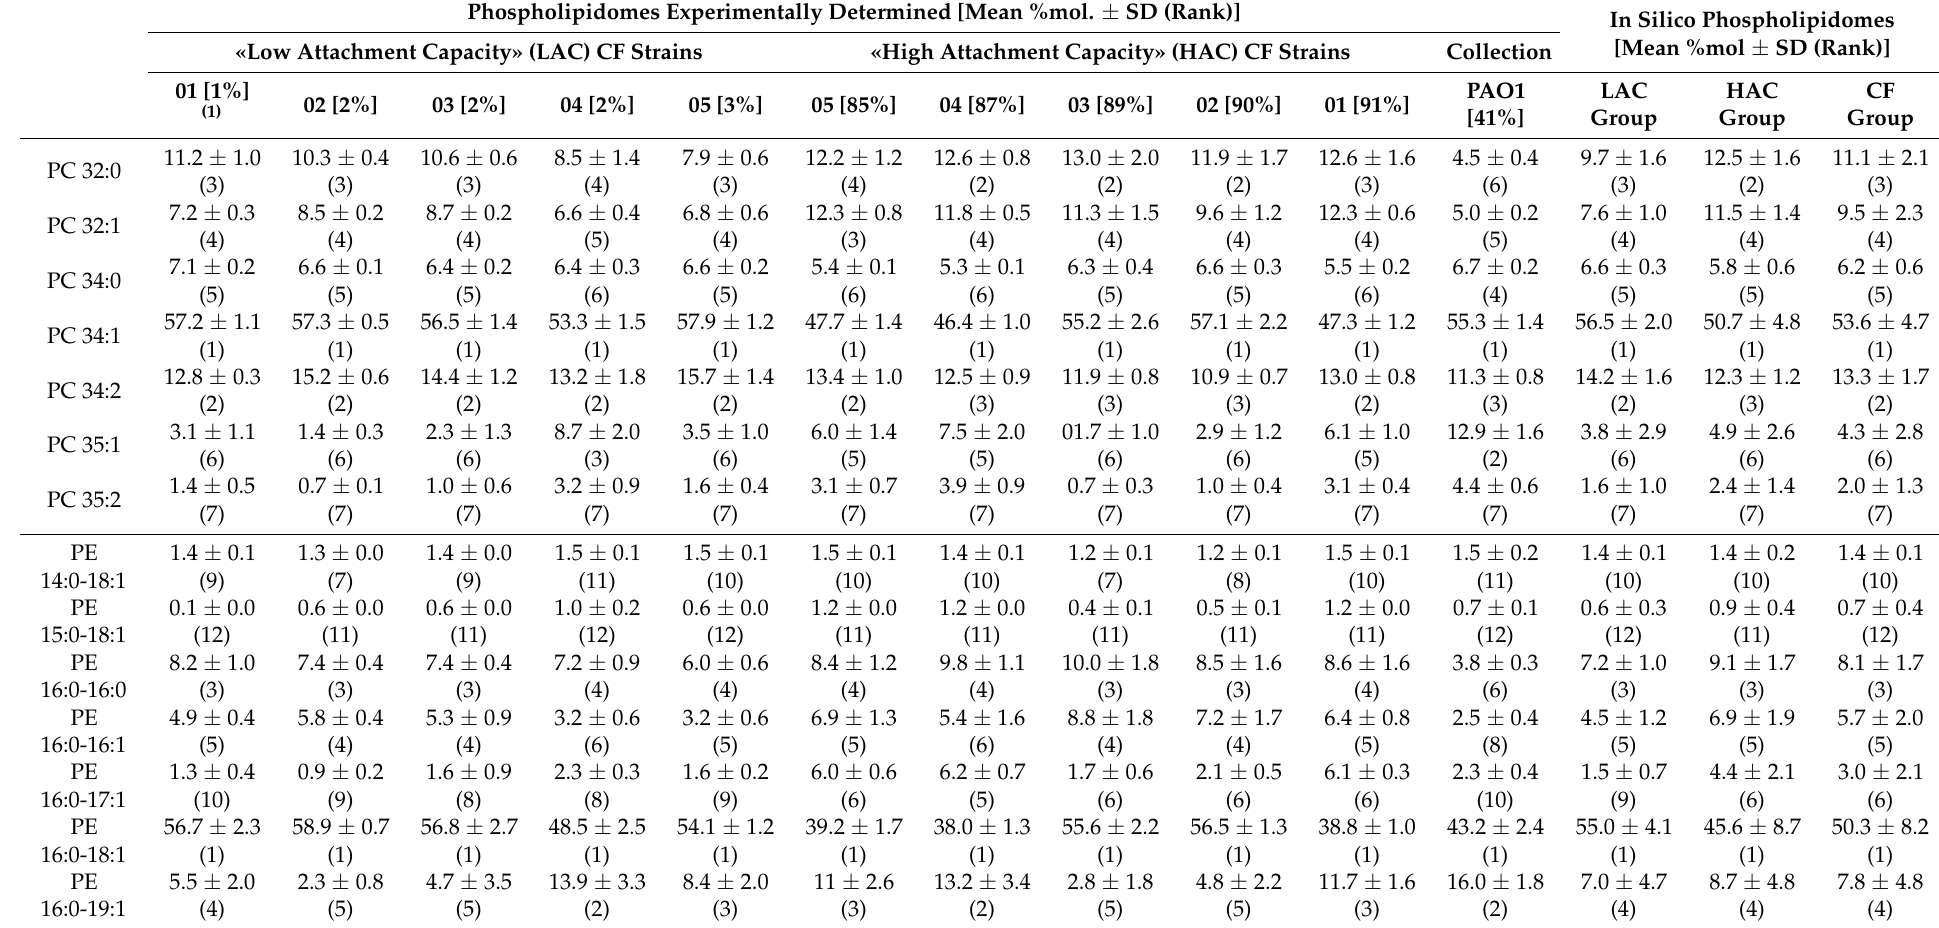
Table 1. Phospholipids quantitation of Pseudomonas aeruginosa collection and clinical strains. The quantitation of a phospholipid (PL) was expressed as its relative quantity among all phospholipids quantified of the same class (%Mol). For each PL quantified in a cystic fibrosis (CF) clinical or collection strain of P. aeruginosa , the indicated value is the mean of eight biological replicates ± standard deviation. Additionally, the rank of a PL is indicated between brackets. This value indicates the ranking of a PL according its relative abundance within a PL class. For instance, the rank of PC 34:1 is 1 in 7 because its relative quantity is the greatest of the seven quantified phosphatidylcholines. (1) : The attachment capacity of a strain is indicated in square